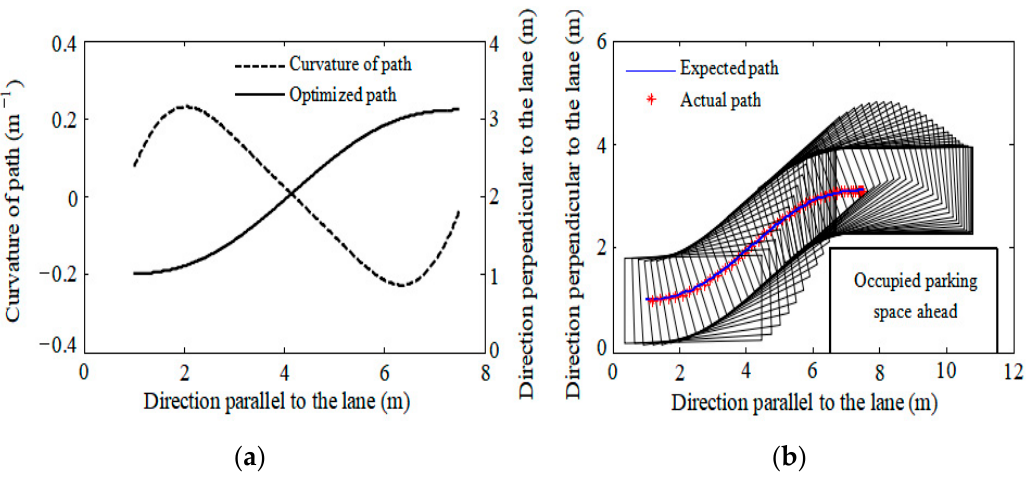
Figure 17. Performance of Bézier curve path trained by radial basis function neural network: ( a ) Path of Bézier curve and curvature of path trained by radical basis function neural network; ( b ) Safety of optimized parking path.